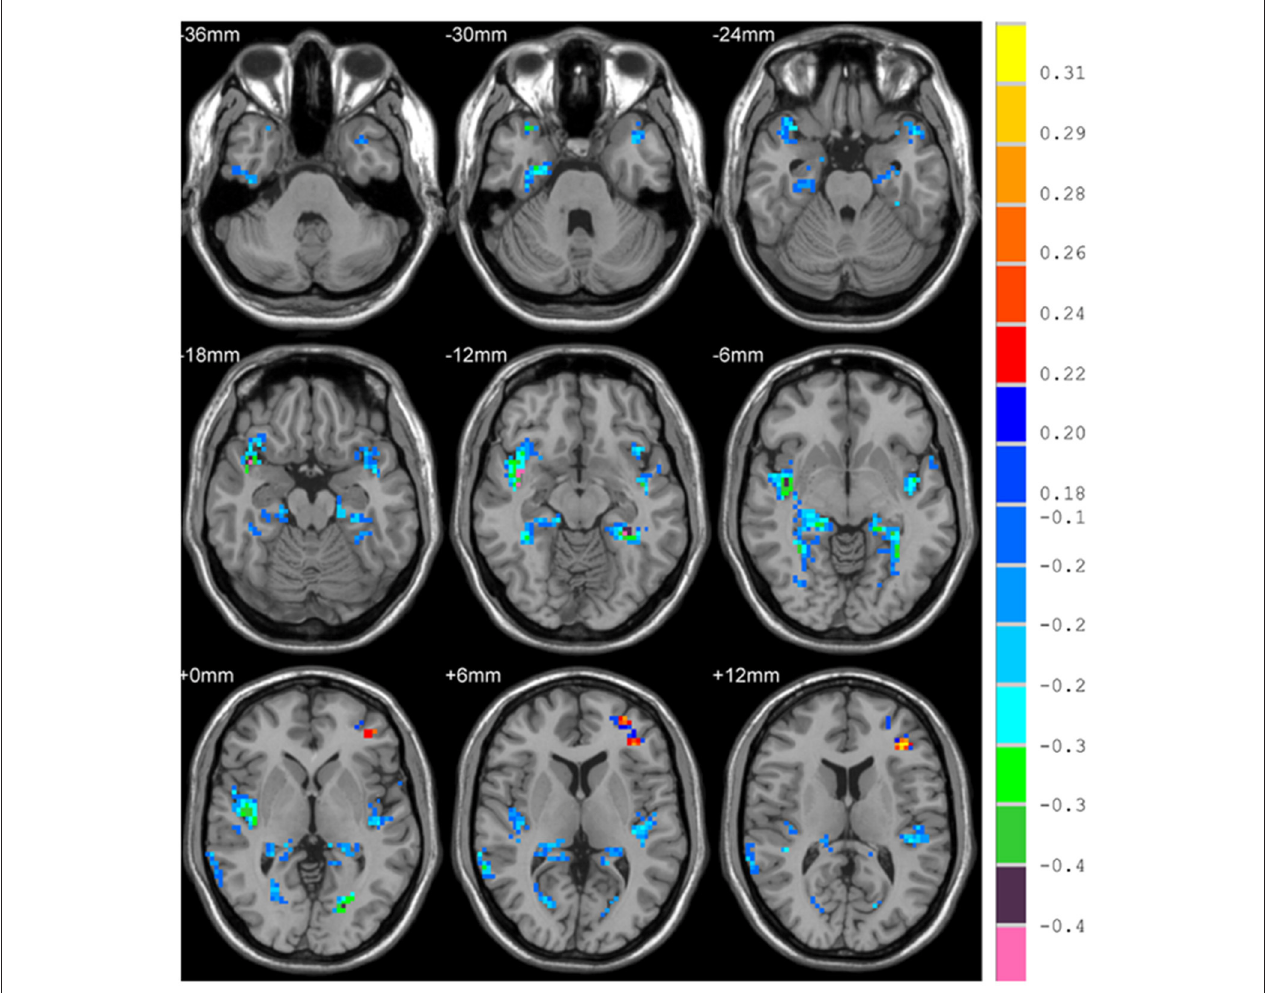
FIGURE 5 | Correlation between HE and age, with positive values showing a decrease of complexity with age.